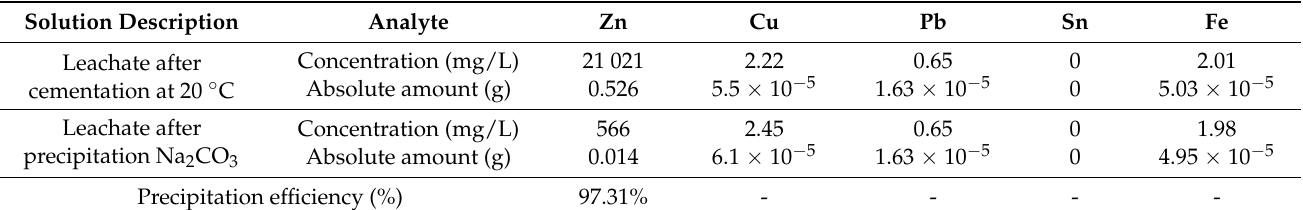
Figure 14. Fraction diagram of [ZnCO 3 ] = 0.310 M precipitation with [Na 2 CO 3 ] = 0.310 M at different ionic strength and complexation of Zn causing lower precipitation efficiency. Table 9. Chemical analysis of solution before and after